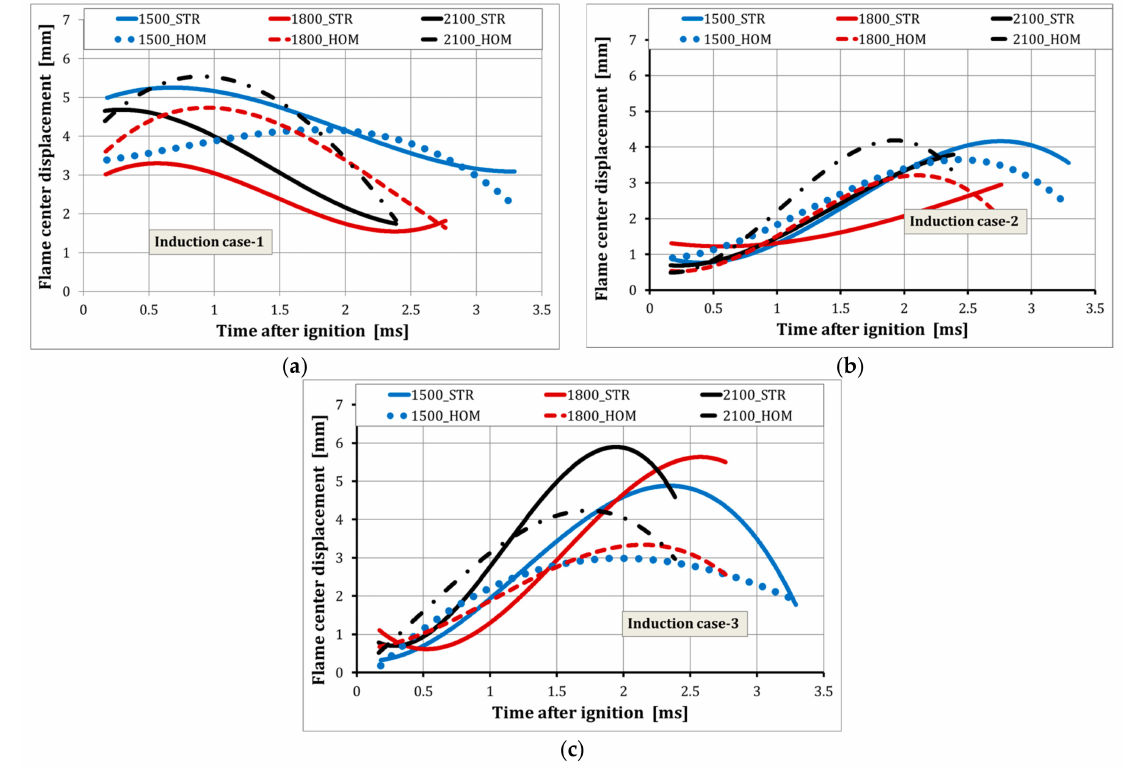
Figure 13. Flame displacement measured from the spark center at variable induction cases ( a ) case 1; ( b ) case 2; and ( c ) case